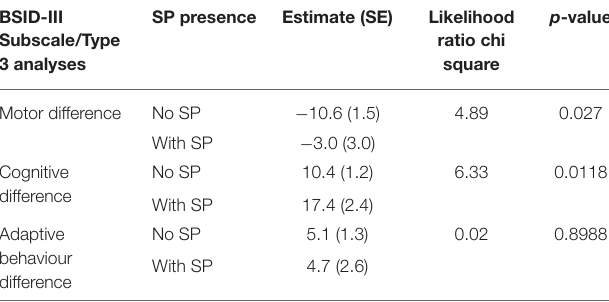
TABLE 8 | Likelihood ratio and Least Squares results for BSID-III and SP outcomes. BSID-III